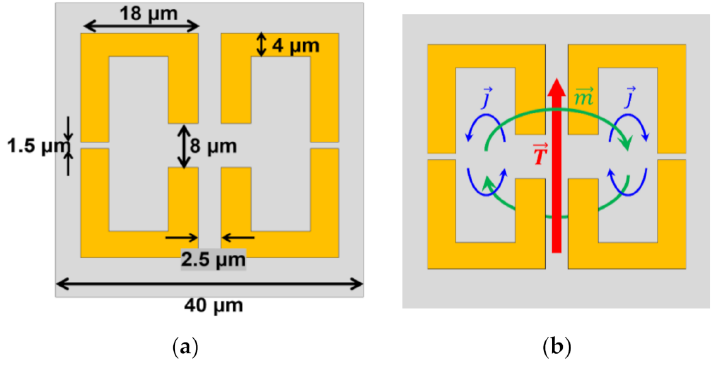
Figure 9. ( a ) The schematic of the metasurface proposed from [199]. The pattern shows two split-ring resonators with big and small gaps and faced against each other. ( b ) The diagram shows how toroidal → T ) can be induced from the magnetic dipole ( dipole ( → J current density (